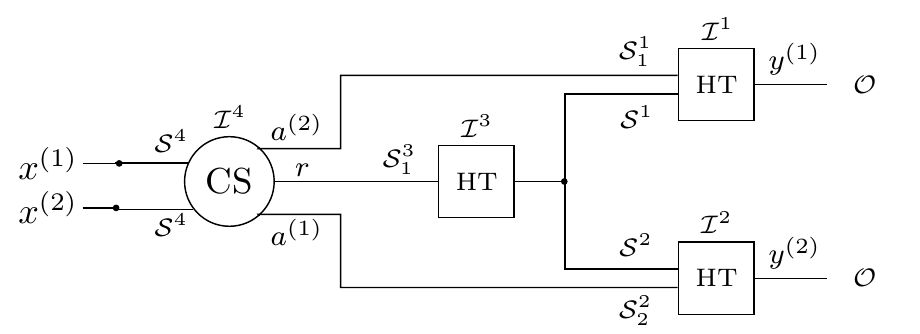
Figure 6: Illustration of common input table as composition of gadgets. Each variable x ( ‘ ) and y ( ‘ ) contains actually n shares x ( ‘ )